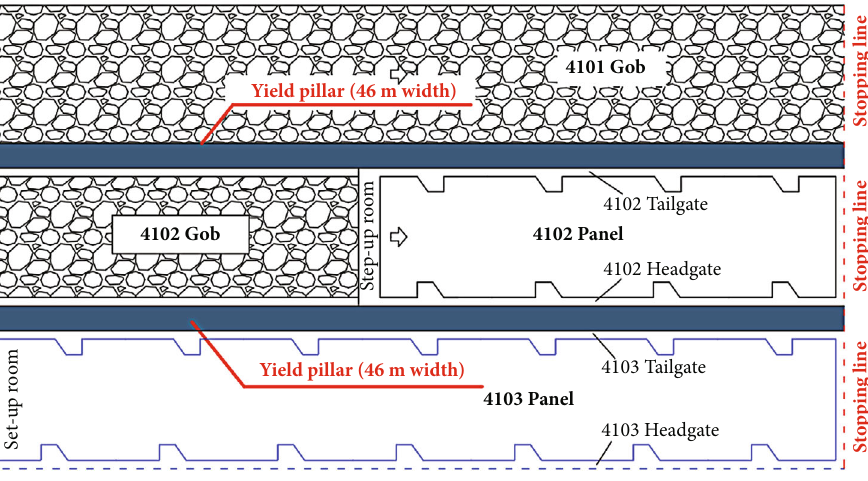
Figure 1: Schematic diagram of the project.